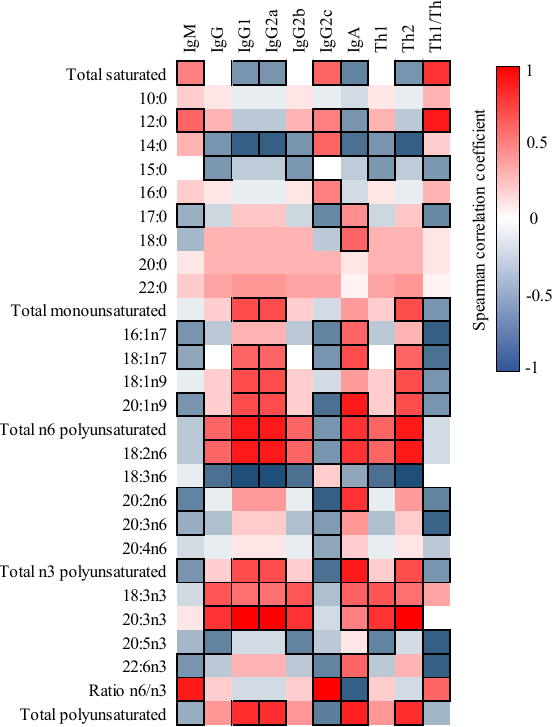
Figure 5. Correlation between the FA composition and Ig present in milk. The Spearman correlation coefficient is represented in the heat map following the color in the legend. Correlations with statistical significance ( p < 0.05) are shown in a bold frame. Results derived from n = 6 for both milk and dams’ plasma.